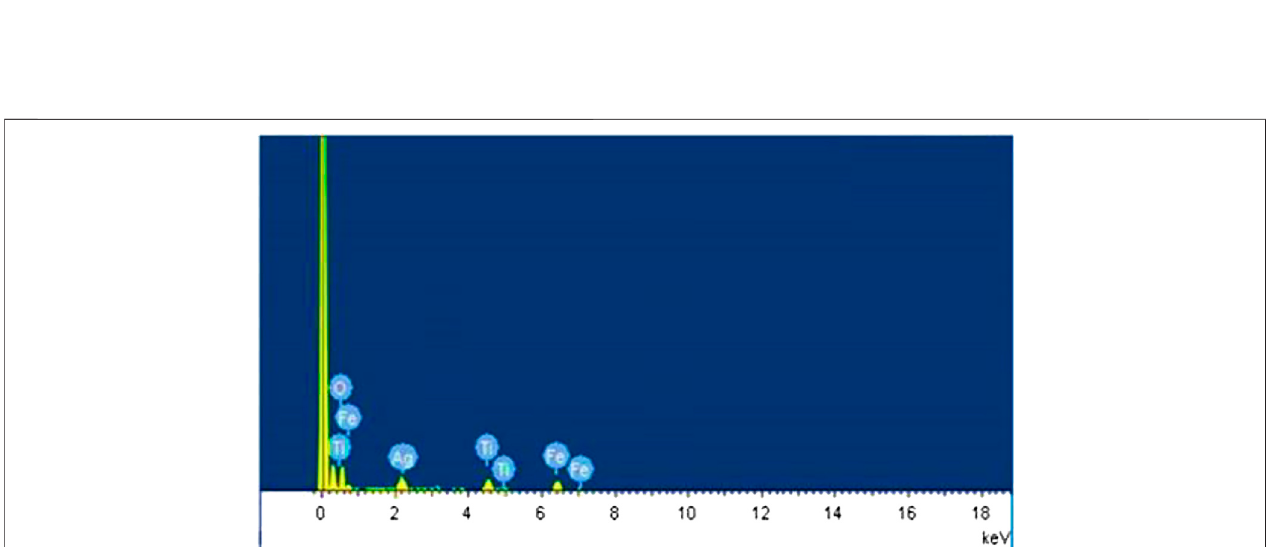
Frontiers in Nanotechnology |